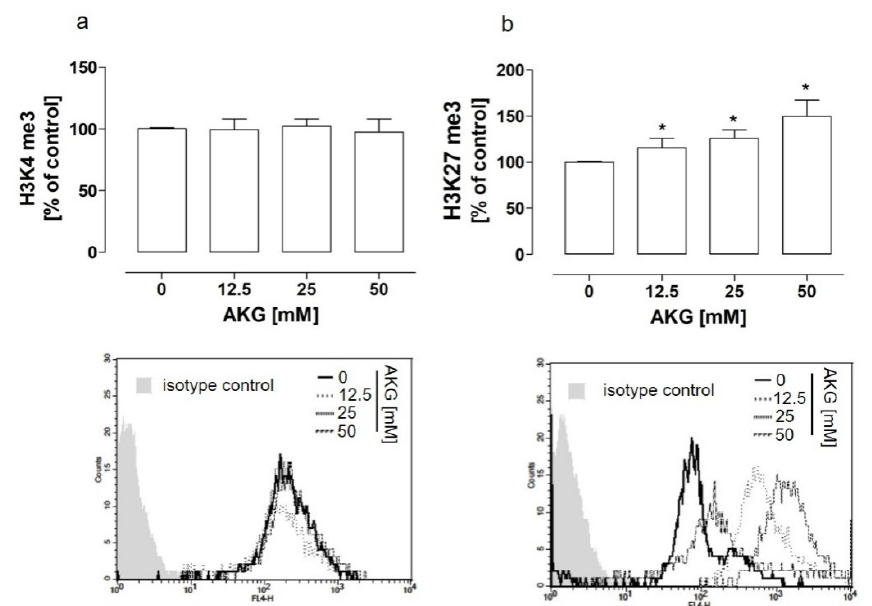
Figure 3. AKG increased the hypermethylation level of lysine 27 in histone H3 via EZH2 methyl- transferase in osteosarcoma cells. The HOS cells were treated with the indicated concentrations of AKG for 72 h. The me3 modifications of histone H3 at lysine 4 ( a ) and 27 ( b ) were detected by means of specific Alexa Fluor 447-conjugated antibodies and quantified by flow cytometry. The control cells (0mM) were also stained with the Alexa Fluor 447-conjugated isotype control. The histograms are representative and correspond with the results presented in the graphs. The results were expressed as a percent of the control (0 mM) ± SD of three independent experiments. Statistically significant differences: * p <0.05 in comparison with the control cells (unpaired T-test).